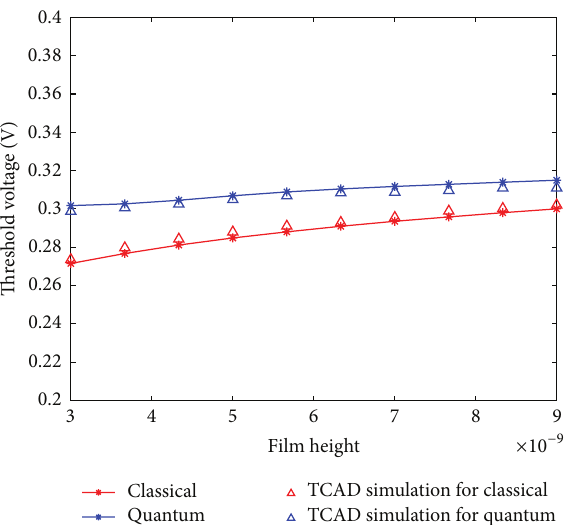
Figure 7: Variation of quantum and classical threshold voltage with film height. Here 𝐿 = 20 nm and 𝑊 = 9